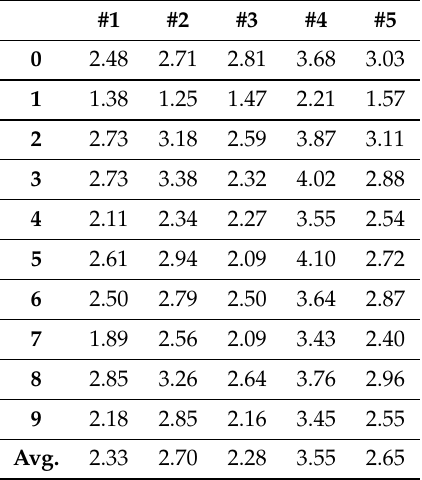
Table 13. The sums of occurrence intensities (values in the encoding) for each visual feature AF5 . It must be emphasized that the results in this table are relative, so they can only be compared to the numbers from the same